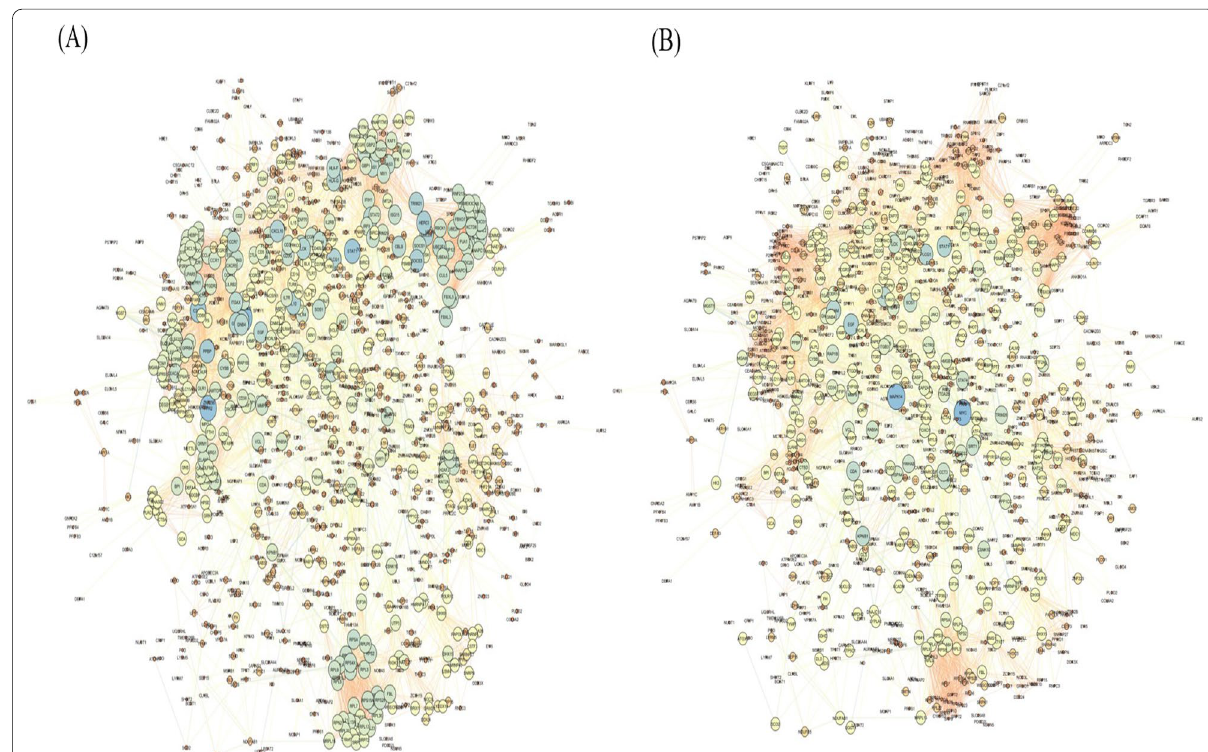
Fig. 5 Topology of the core network consisting of 1058 nodes connected via 6672 edges. A The key nodes were mapped with respect to degree and against the CC. The size of the nodes corresponds to their degree values (low value to smallest size) and colour to their CC values (bright colour); B the key nodes were mapped with respect to BC and against the CC. The size of the nodes corresponds to their BC values (low value to smallest size) and colour to their CC values (bright